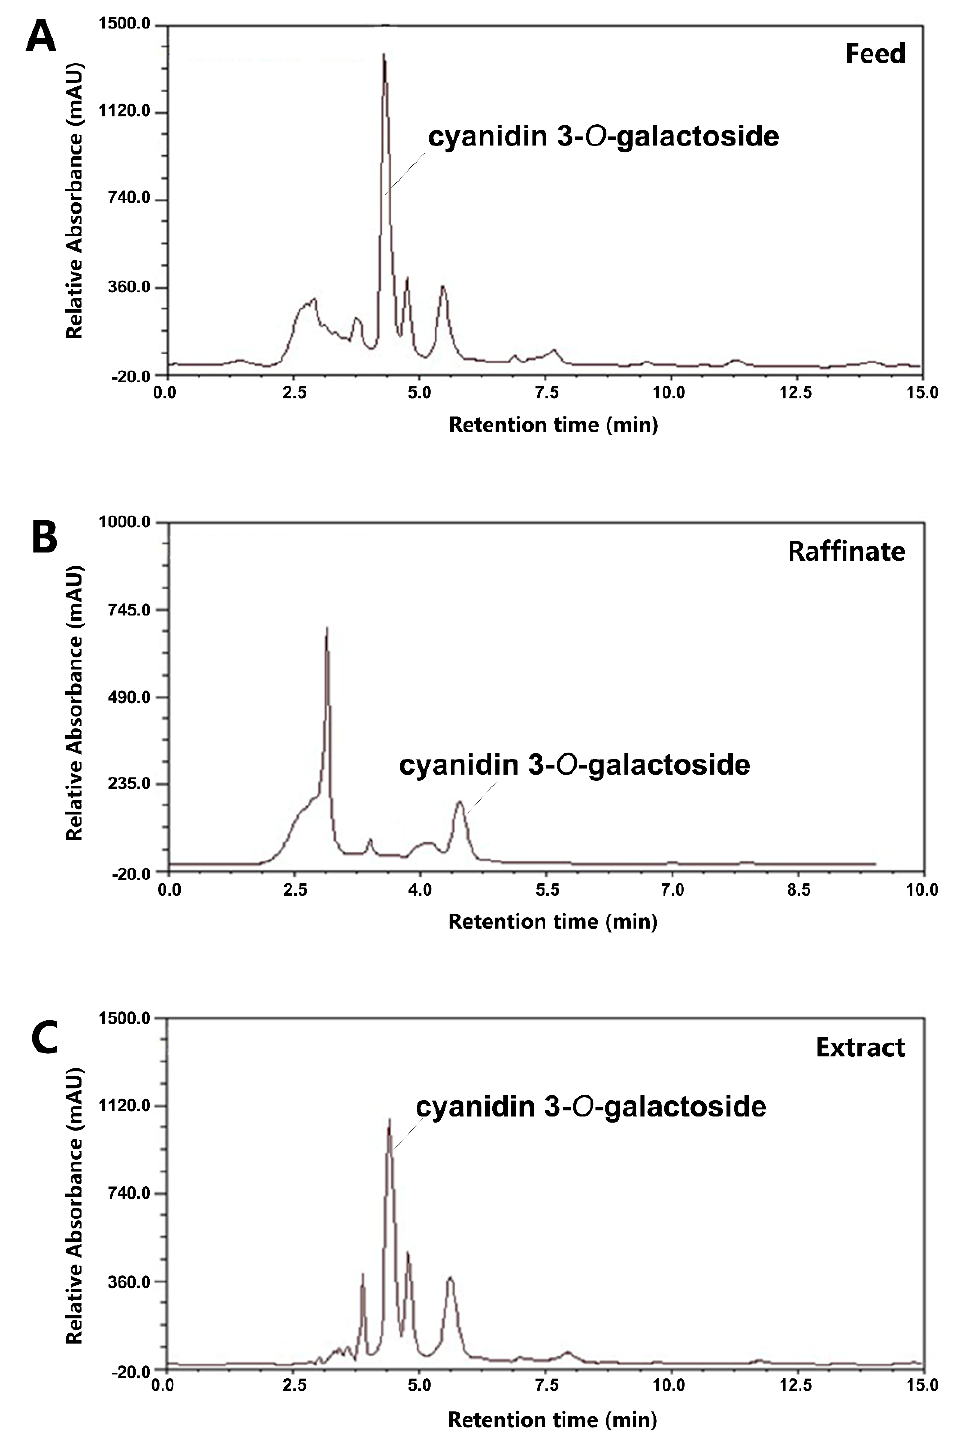
Figure 2. HPLC-PDA chromatogram of the feed ( A ), the raffinate ( B ), and the extract ( C ) during the SMB process monitored at 278 nm.